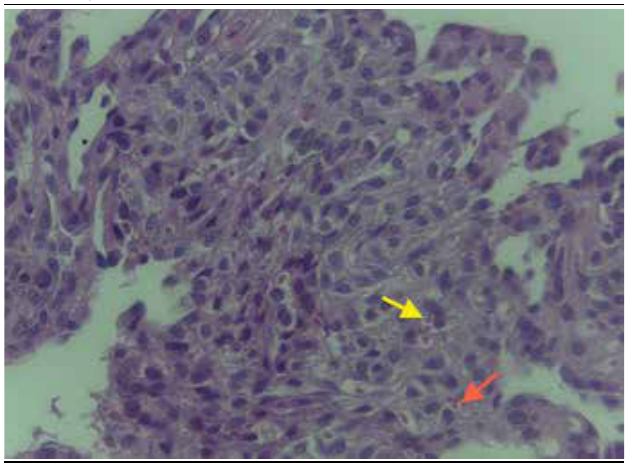
figuRE 4 − Blood vessels of varying sizes lined by endothelial cells with an epithelioid pattern (HE, 400×) HE: hematoxylin and eosin.